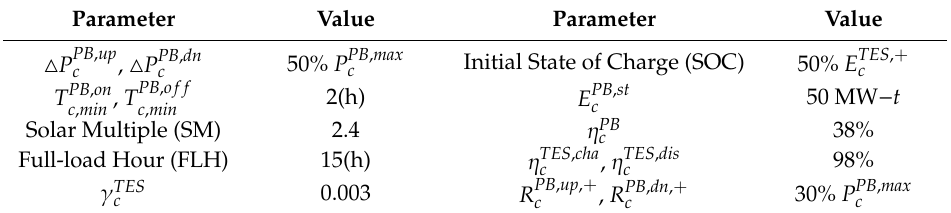
Table 2. Parameters of CSP station. Table 1. Capacity of generators in the modified 24-bus IEEE reliability power system.